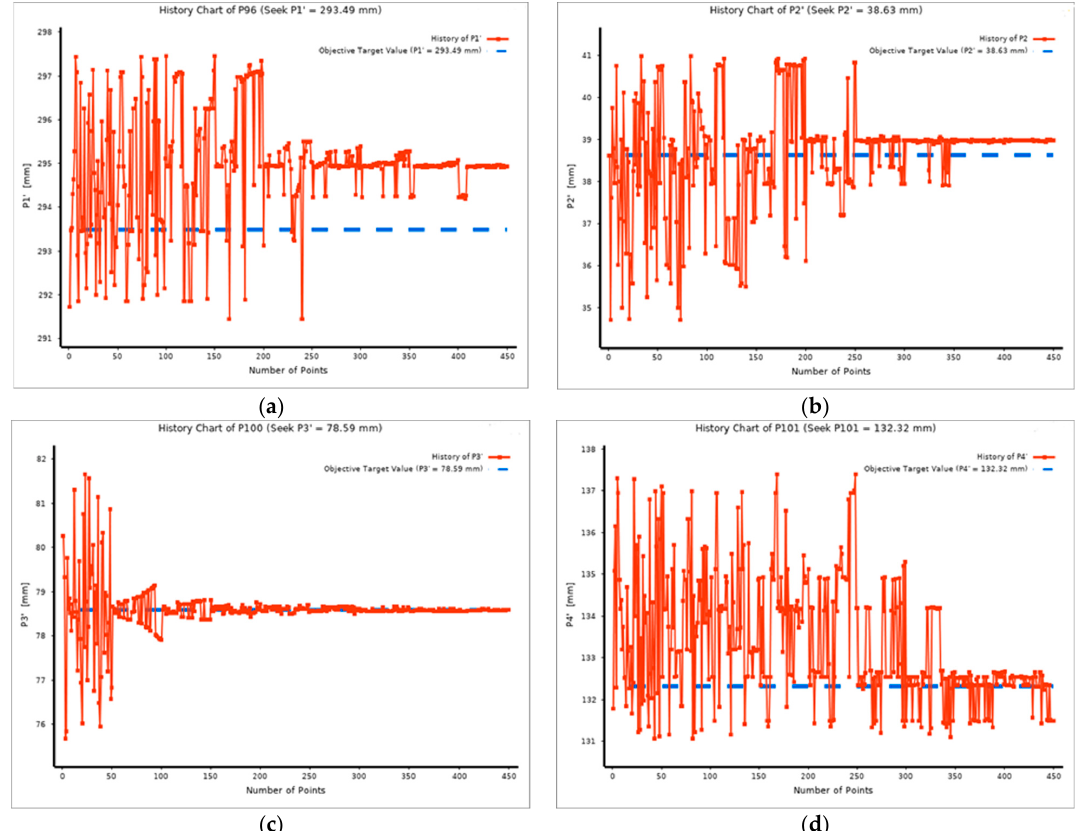
Figure 13. Post-HIP dimensions for each point during optimization (for mentioned parameters from Figure 3a): ( a ) P1 parameter; ( b ) P2 parameter; ( c ) P3 parameter; ( d ) P4